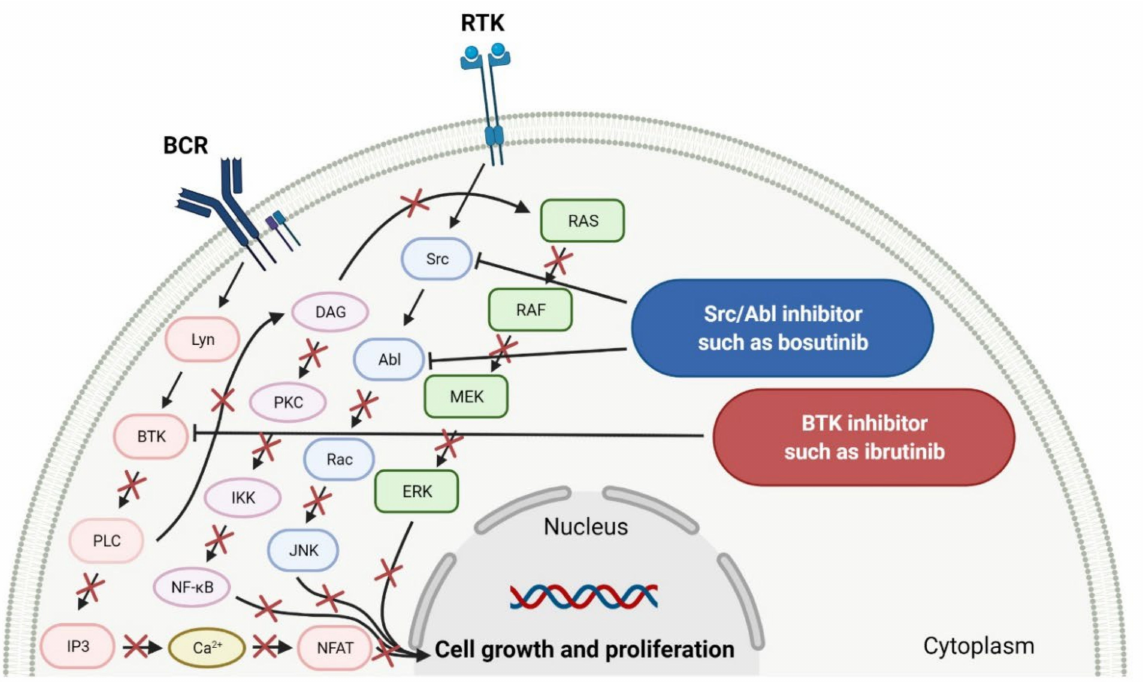
Figure 1. Mode of action of tyrosine kinase (TK) inhibitors such as non-receptor BTK and Src/Abl